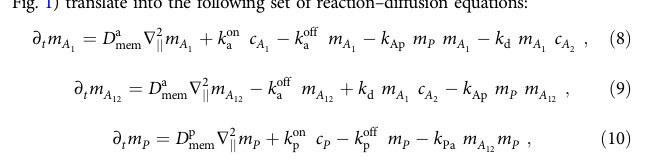
Fig. 1) translate into the following set of reaction – diffusion